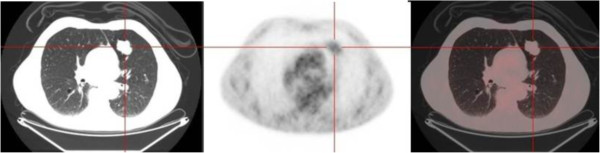
The integrated FDG-PET/CT reveals a large TC (42 mm) demonstrating low uptake (SUVmax 2.2). From left to right: CT, PET and fused image.